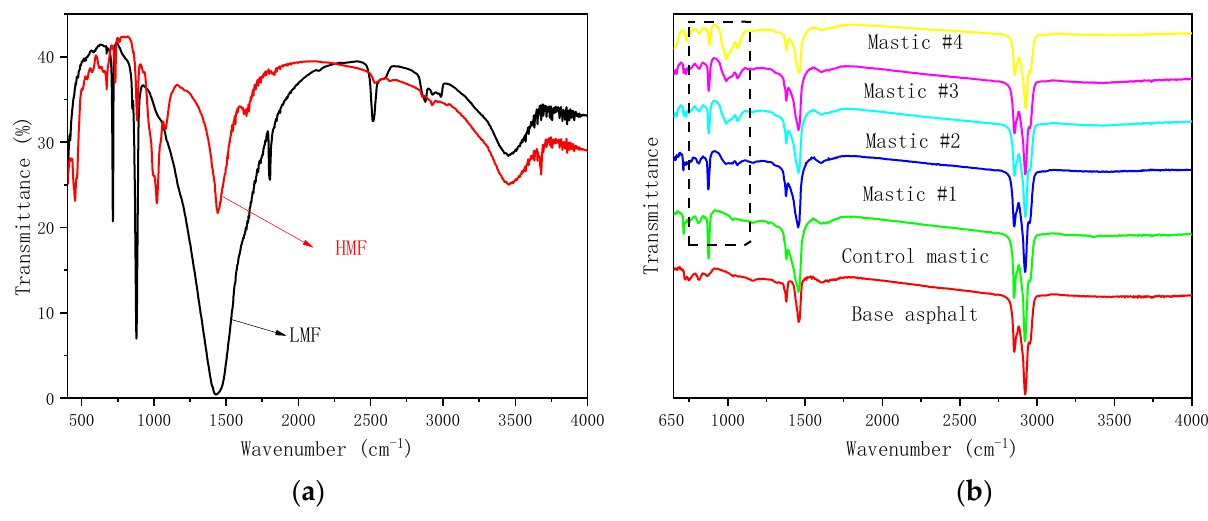
Figure 6. FTIR spectrums. ( a ) LMF and HMF; ( b ) base asphalt and asphalt mastic.